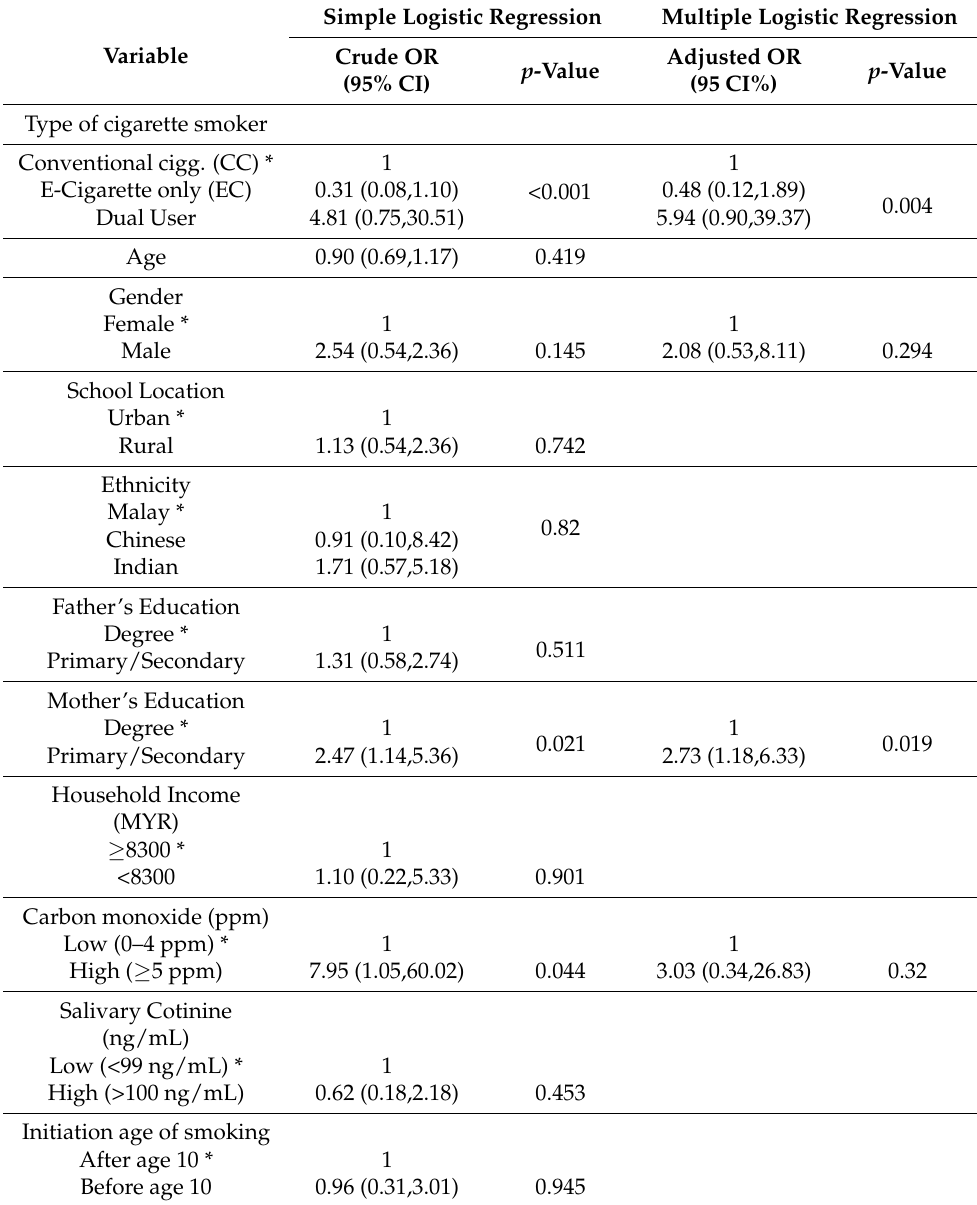
Table 3. Factors associated with nicotine dependence among different types of smoking classification of adolescent smokers (addicted, 1; not addicted, 0). Simple Logistic Regression Multiple Logistic Regression Variable Adjusted OR Crude OR p -Value p -Value (95 CI%) (95% CI) Type of cigarette smoker Conventional cigg. (CC)